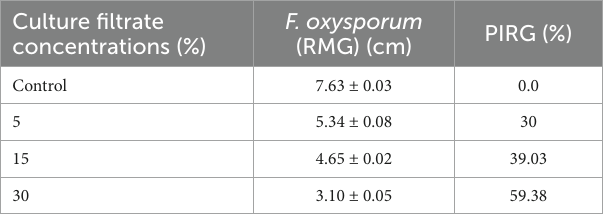
TABLE 2 Effect of different concentrations of T. asperellum culture filtrate against F. oxysporum. Culture filtrate concentrations